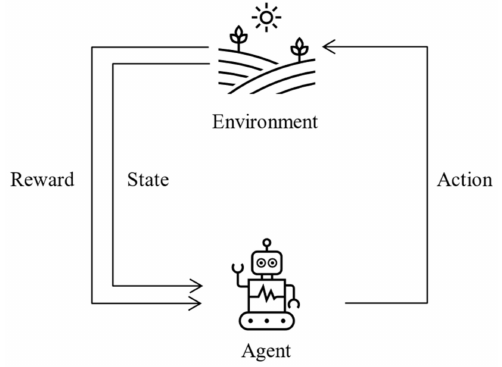
Figure 2. A typical framework of RL scenario.